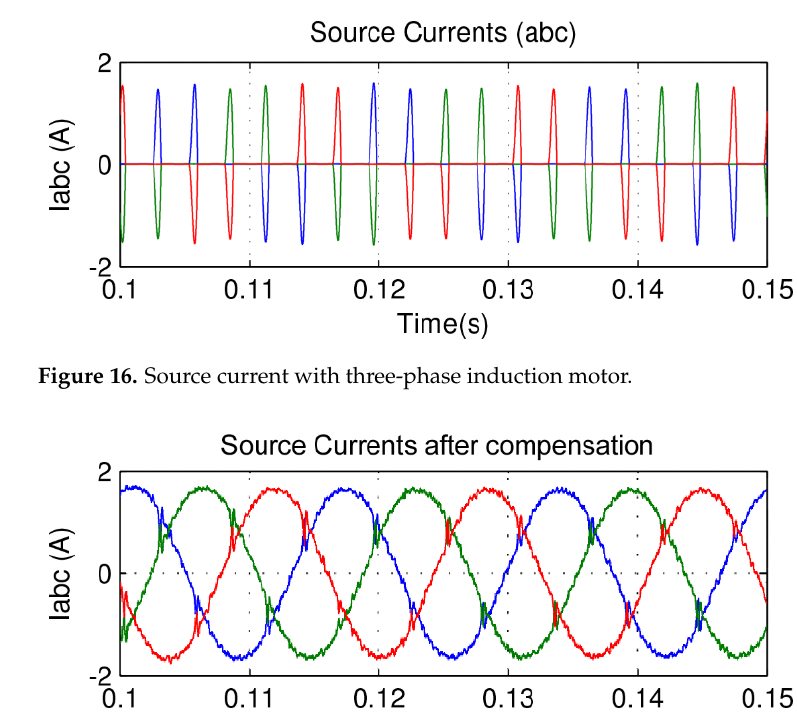
Figure 17. Source current with APF compensation.